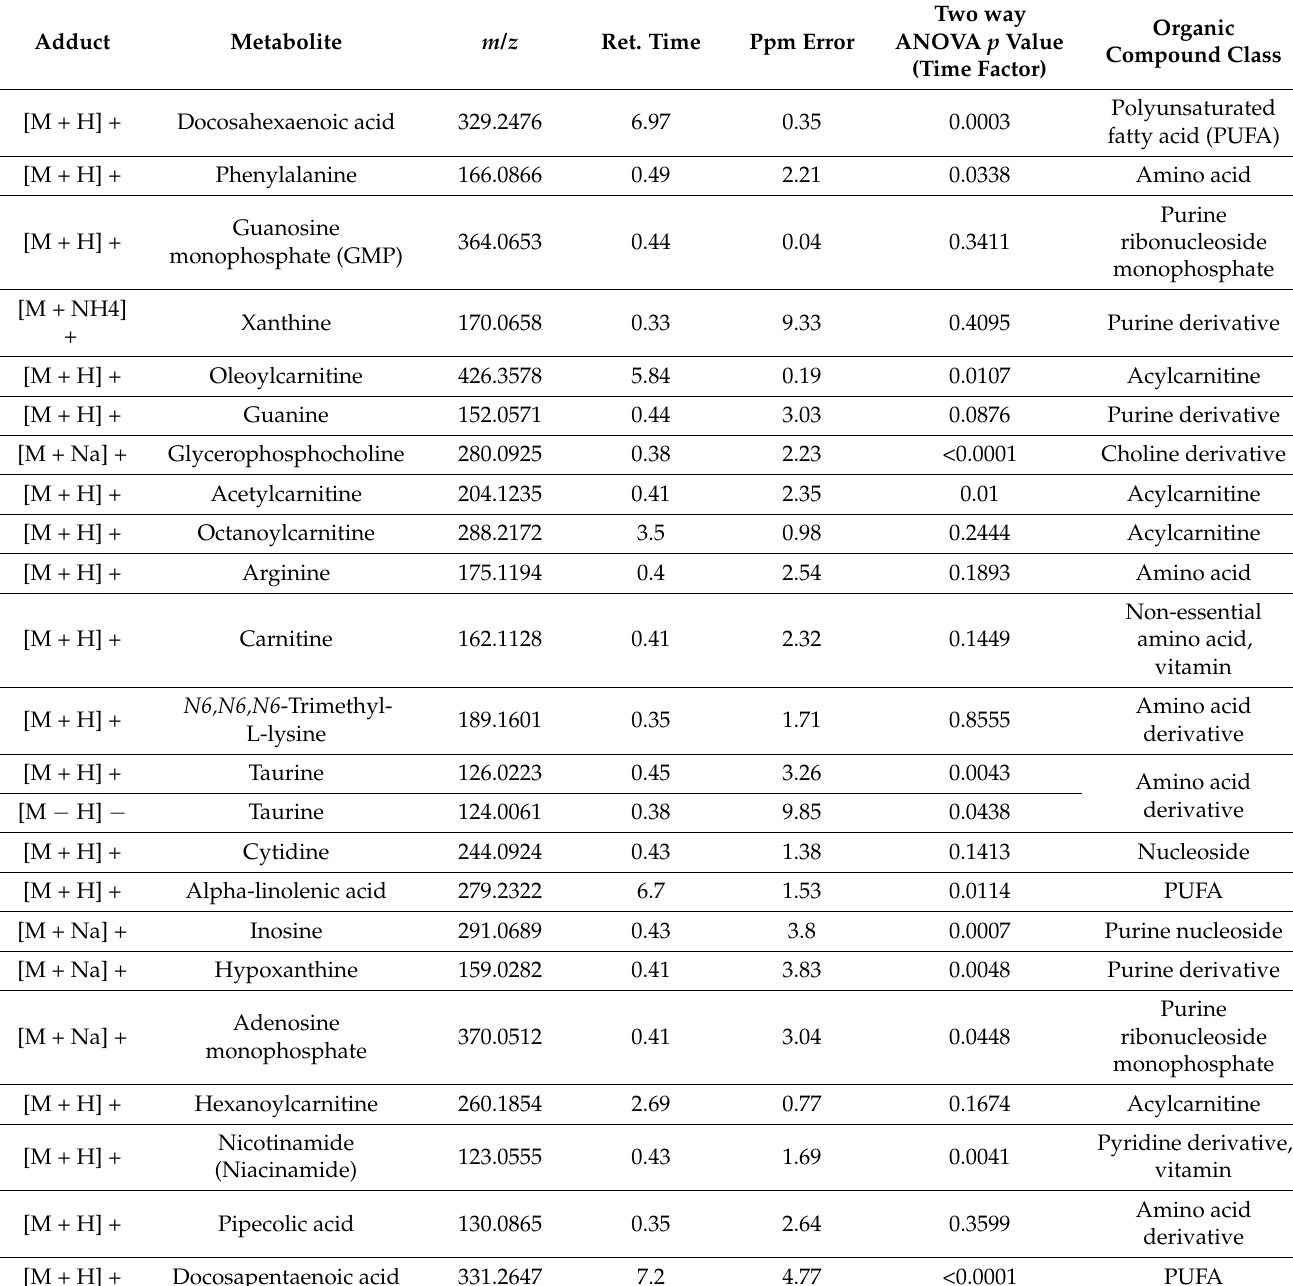
Table 1. Validate Metabolites through